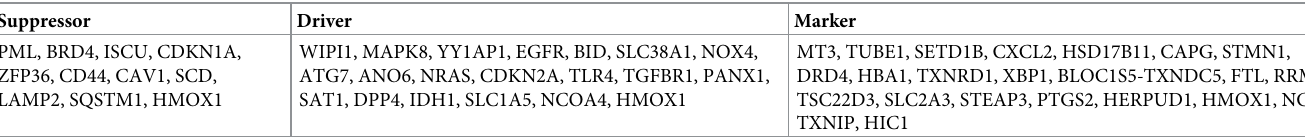
Table 1. The DE-FRGs were classified as ferroptosis driver, suppressor, or marker. Suppressor